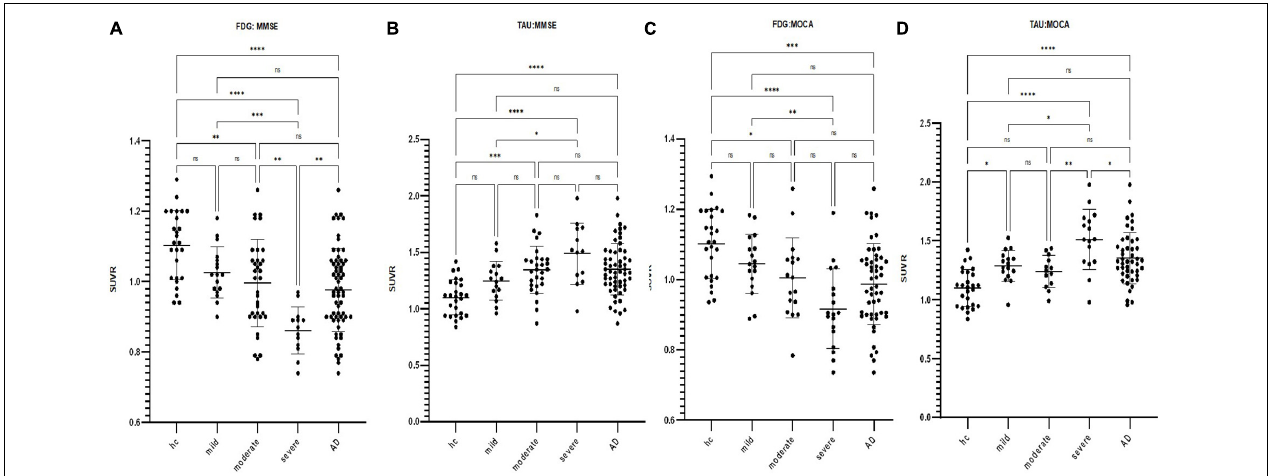
FIGURE 2 | Scatterplot of the standardized uptake value ratio (SUVR) distribution in the cerebral cortex for FDG and tau PET images by subgroup according to respective neuropsychiatric scores (* p < 0.05, ** p < 0.01, *** p < 0.001, **** p < 0.0001). (A) FDG SUVR distribution in the HC group and mild/moderate/severe AD subgroups as defined by MMSE. (B) Tau SUVR distribution in the HC group and mild/moderate/severe AD subgroups as defined by MMSE. (C) FDG SUVR distribution in the HC group and mild/moderate/severe AD subgroups as defined by MOCA. (D) Tau SUVR distribution in the HC group and mild/moderate/severe AD subgroups as defined by MOCA.